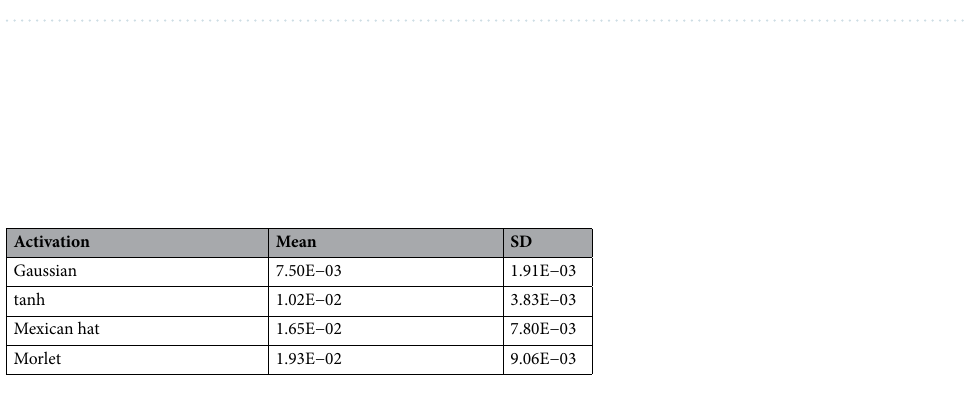
Figure 16. Comparison of the results of proposed method using Gaussian wavelet with the exact solution for different values of t.